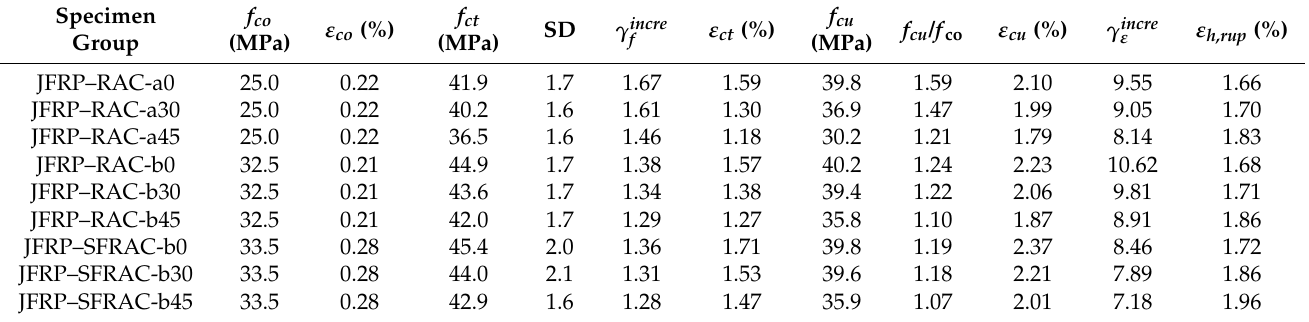
Table 7. The compressive properties of the specimens.